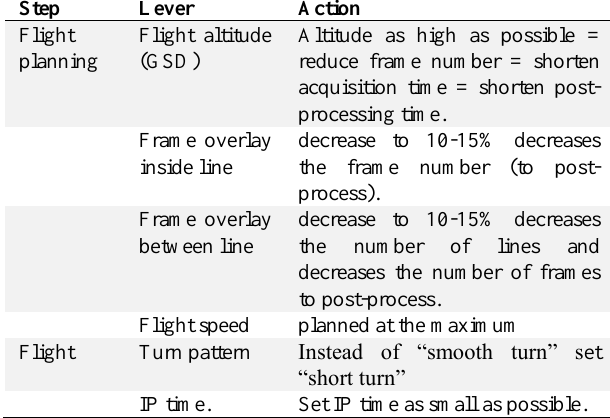
Table 2. Possible levers for shortening data